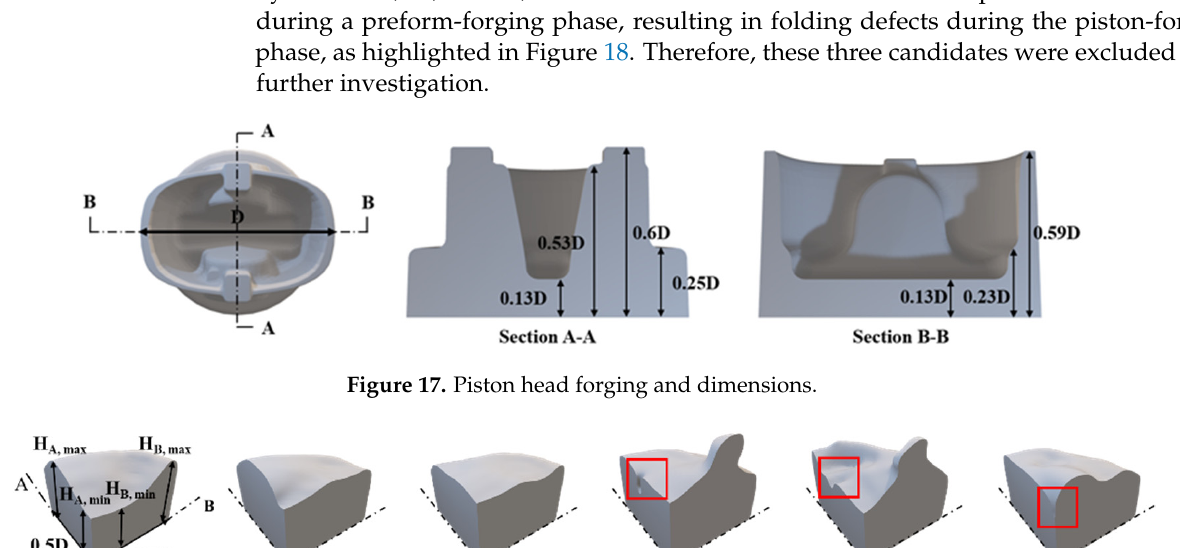
Figure 16. ( a ) The preform design from the literature [26], ( b ) preform design by CNN#5, and ( c ) experimental forging force–punch patch curves from the literature from FEM for the designed preforms by CNN sub-models.